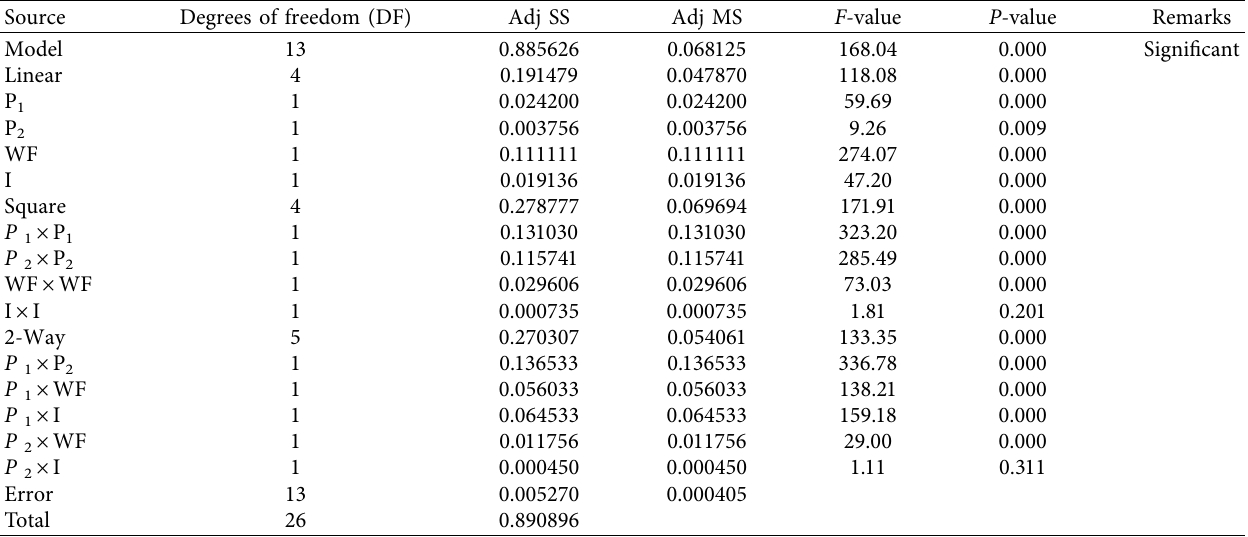
Table 6: Results from ANOVA.